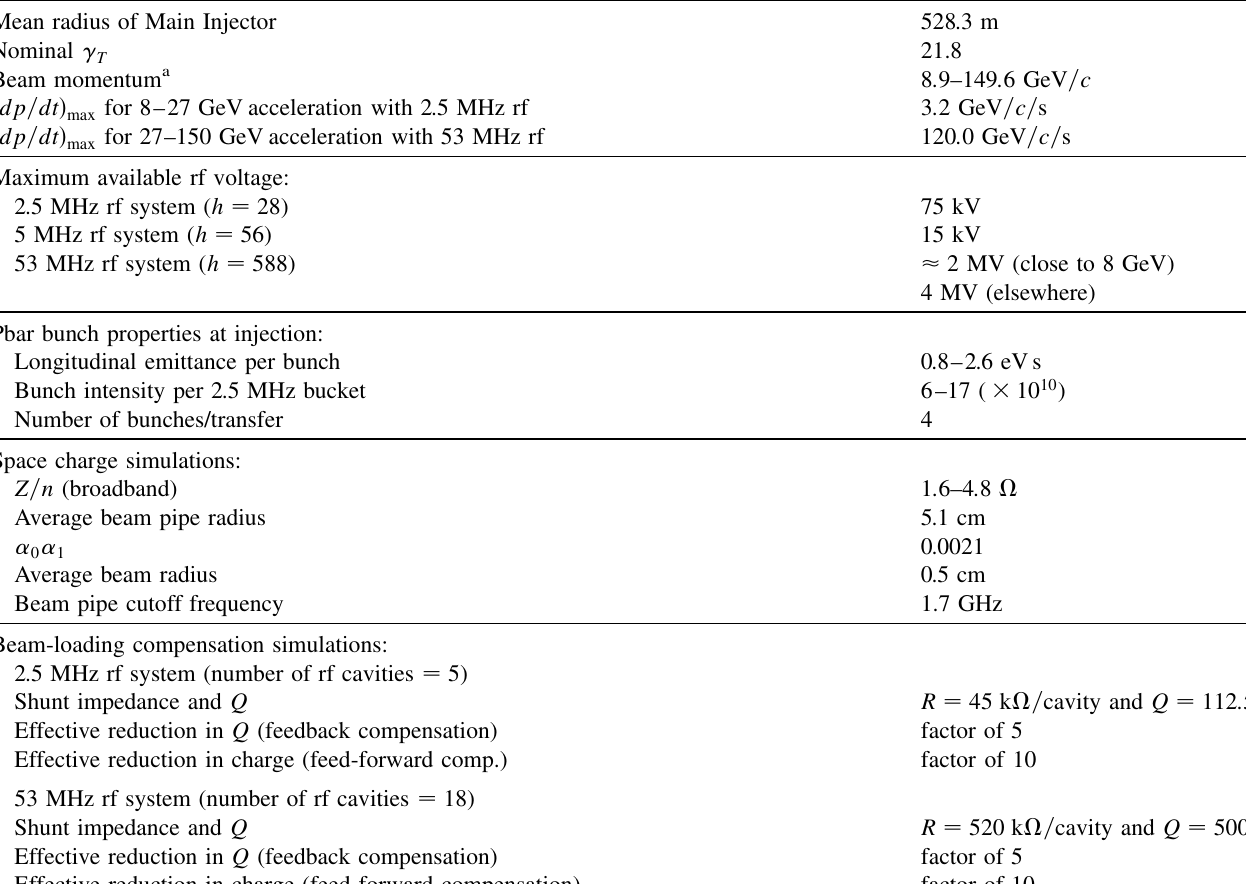
TABLE I. Fermilab Main Injector parameter list used for the numerical